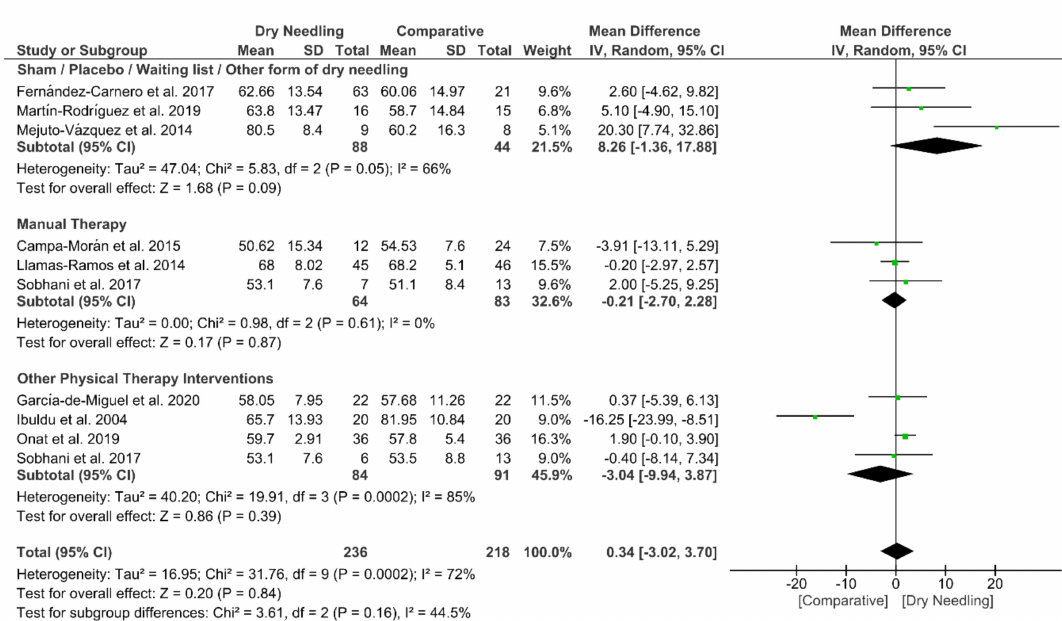
Figure 9. Mean di ff erences (MD) comparing the e ff ects of dry needling alone against sham / placebo / waiting list / other forms of dry needling or manual therapy or other physical therapy interventions on the cervical range of motion in extension ( A ) immediately after and ( B ) at the short-term. SD: standard deviation; CI: confidence